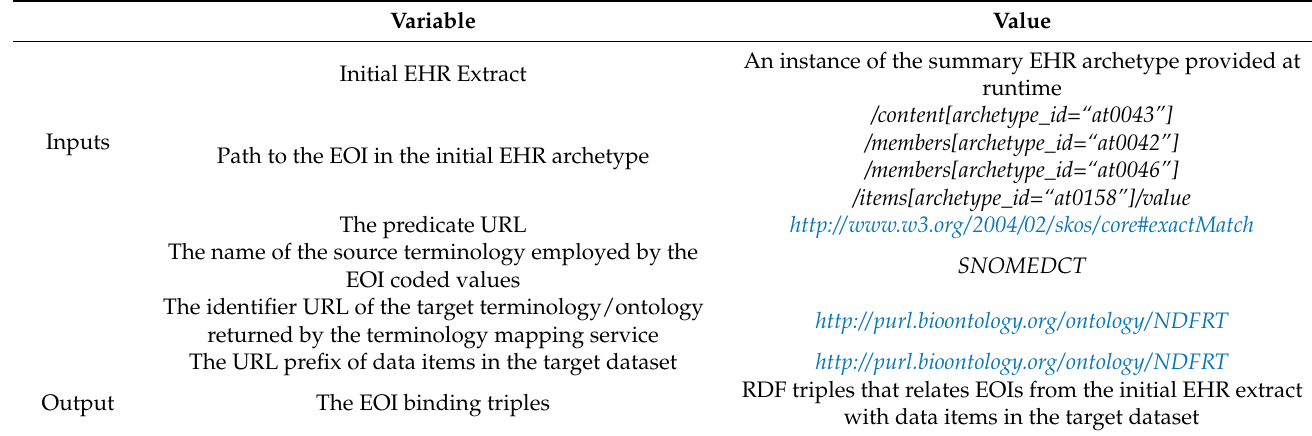
Table 2. Inputs and output of the automatic procedure to build the EOI binding triples for the disease-related treatments’ EHR augmentation.